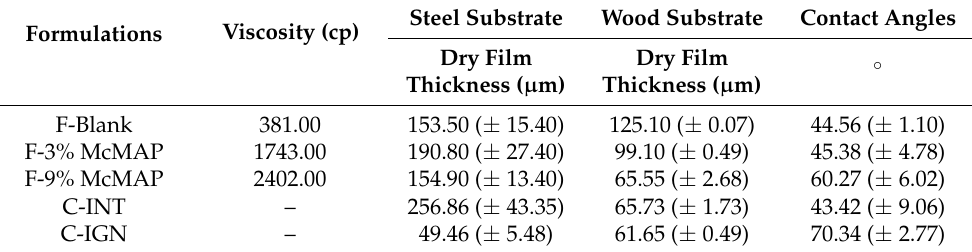
Table 5. Evaluation of Film Properties of McMAP Formulations and Commercial Coatings.